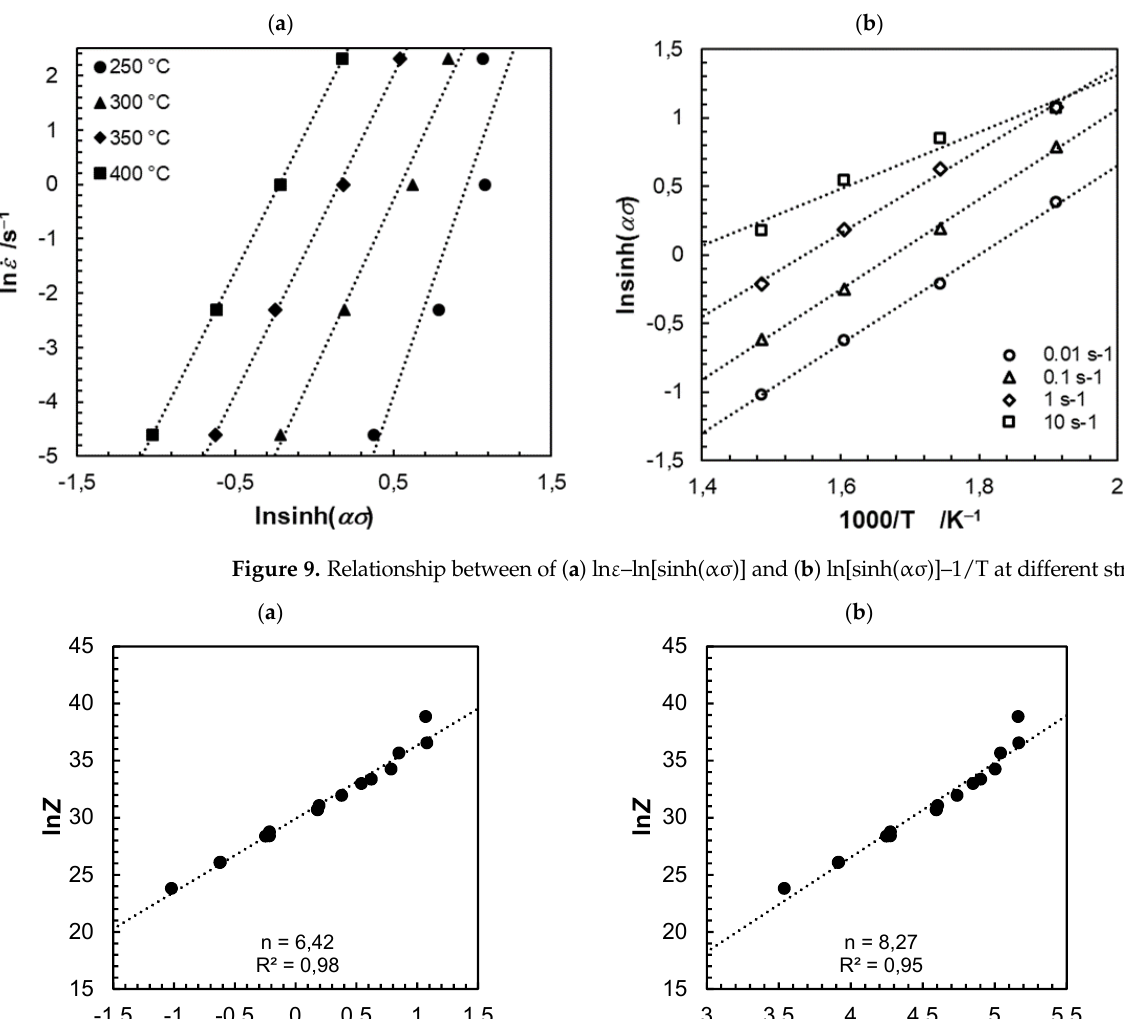
Figure 8. Relationship between ln ε and ( a ) ln σ ( b ) σ .